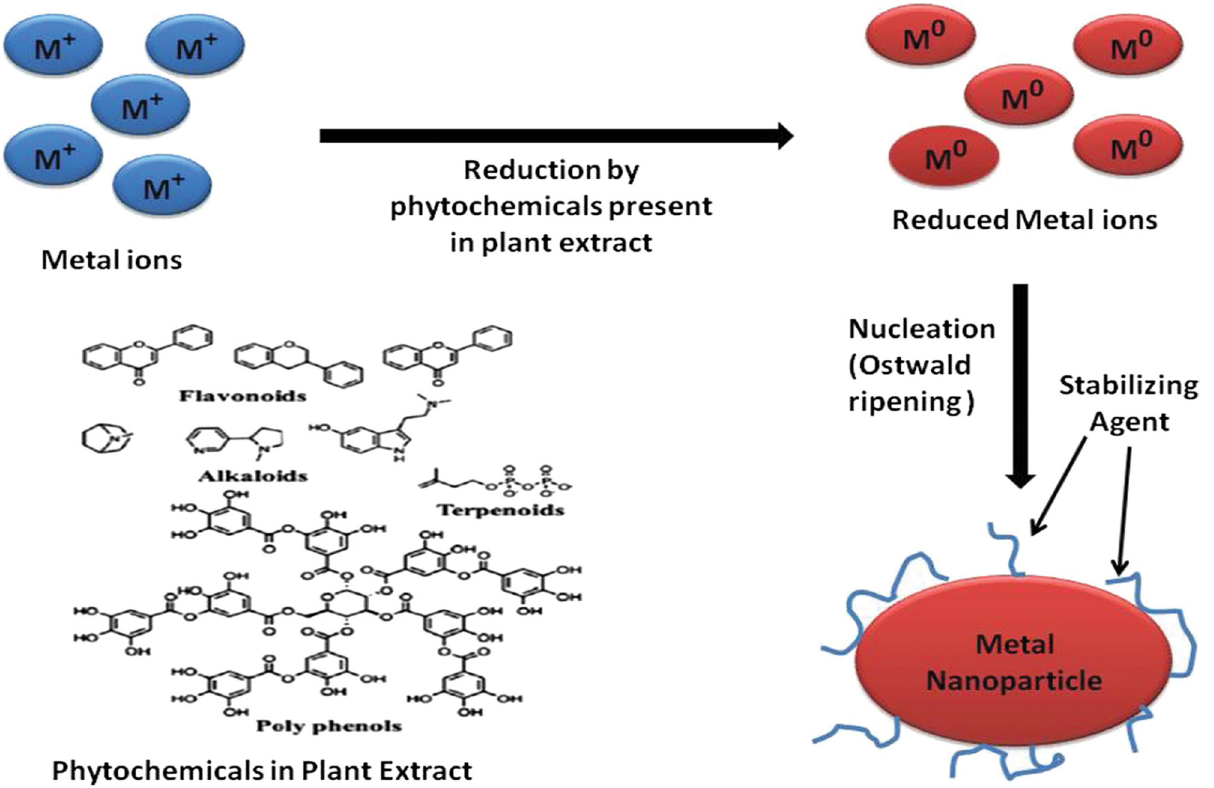
Figure 4: Nanoparticle consistency mechanism by plant leaf extract [ 31 ] .